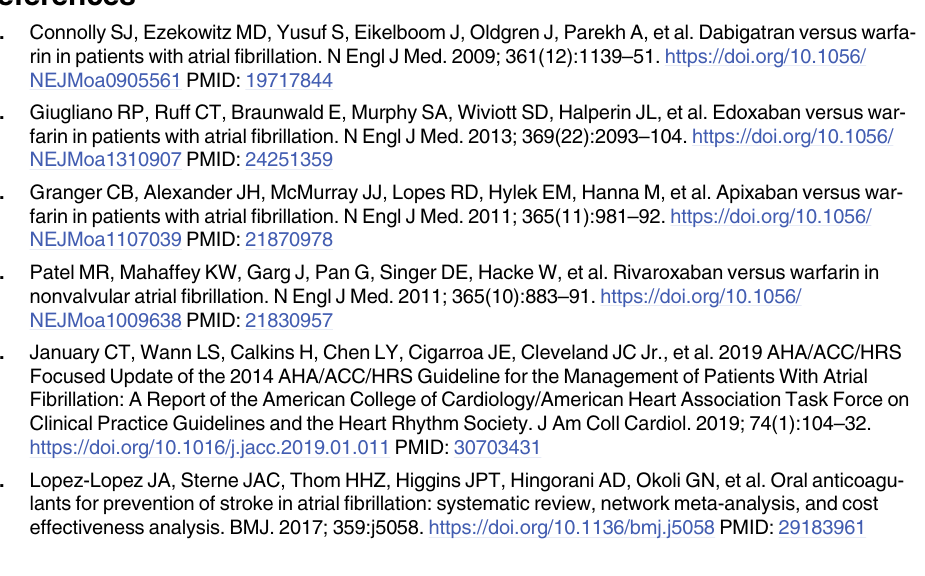
S2 Table. Identified DRP items in the initial service (bold text) and their corresponding PCNE-DRP type and cause in warfarin group, n =